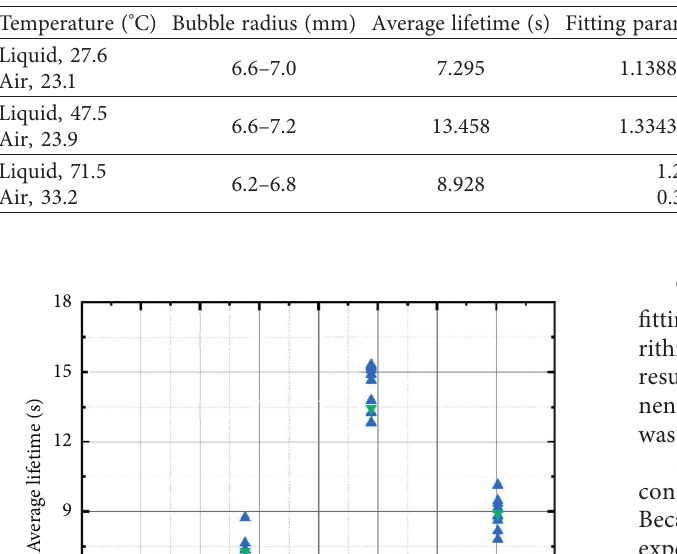
Figure 10: Marangoni effect of bubble drainage diagram [1]. Table 2: Fitting results of bubble lifetime distribution of 0.05 g/L TiO 2 aerosol suspension for different conditions.